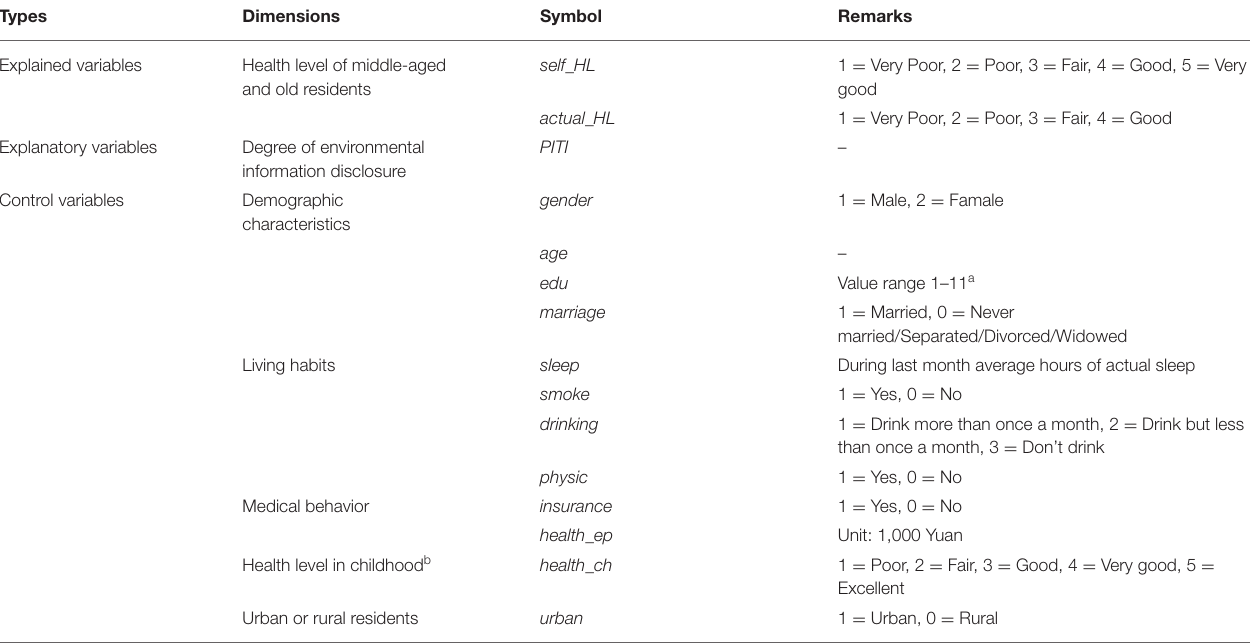
TABLE 3 | Variable